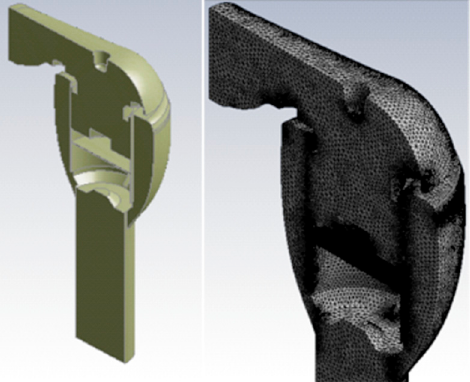
Figure 4. Geometry and meshing structure of a commercial air valve for ANSYS Fluent analysis.